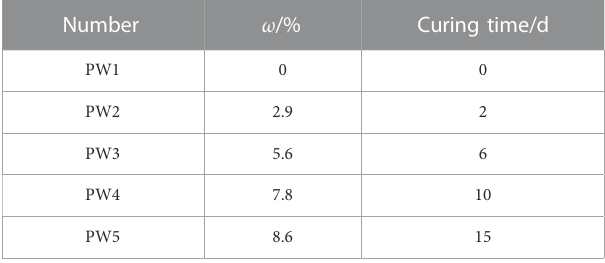
TABLE 1 Number of split rock samples and moisture